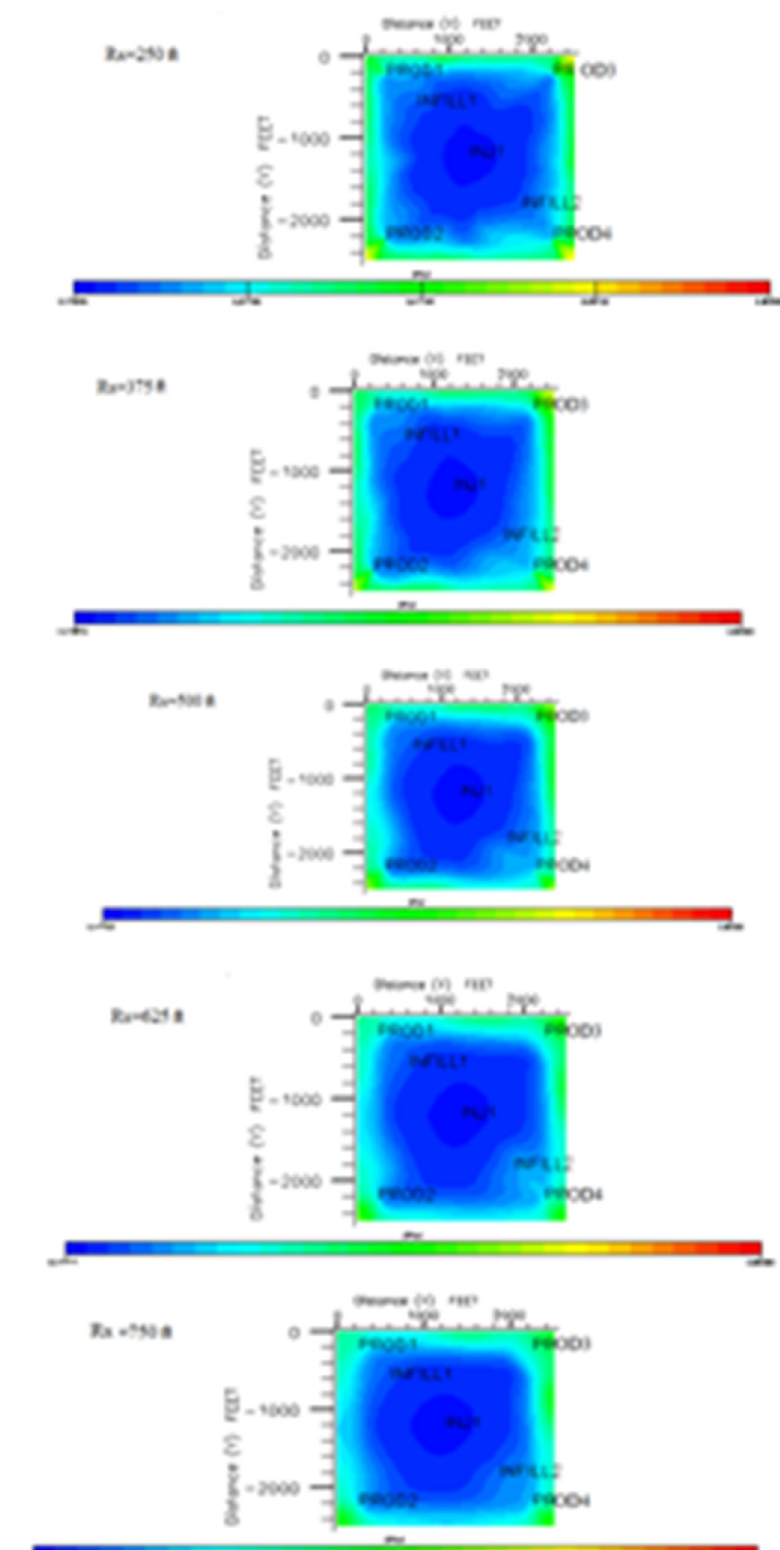
Fig. 9 Final oil saturation distribution after 40 years (end of simulation) for each